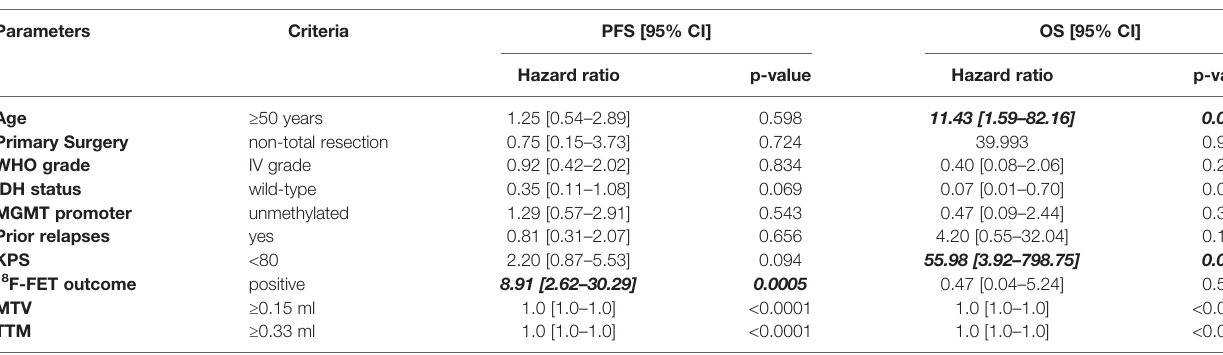
TABLE 5 | Multivariate